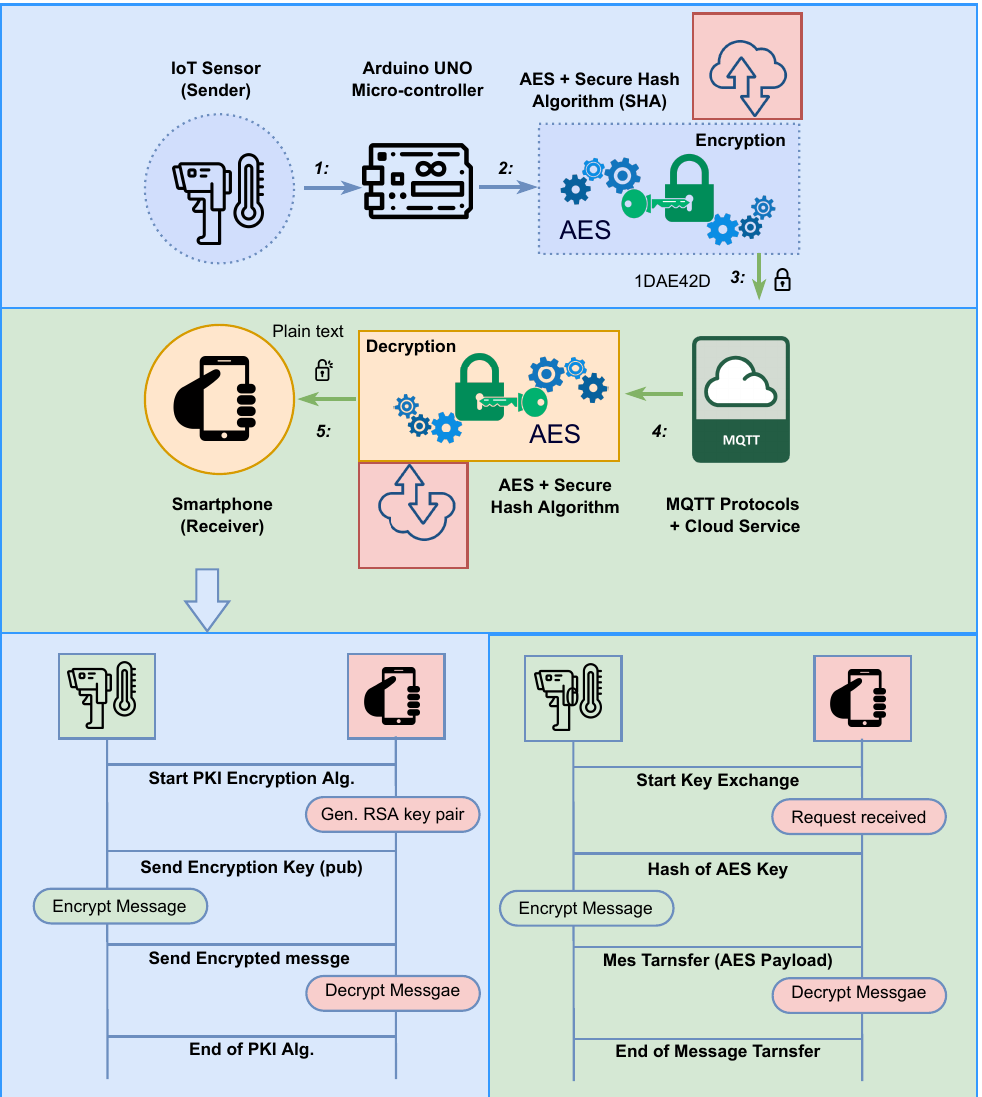
Figure 5. Experimental IoT Environment Setup for Evaluating the Proposed Enhanced AES Based on Chaos and